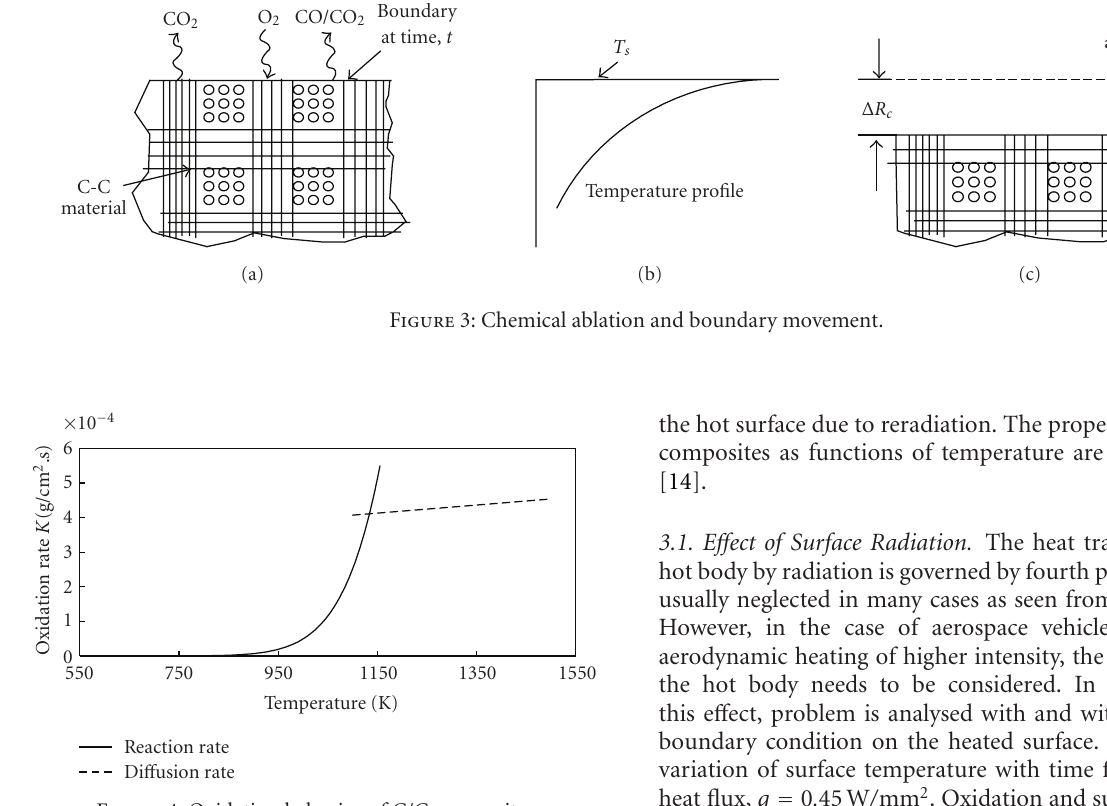
Figure 4: Oxidation behavior of C/C composite.